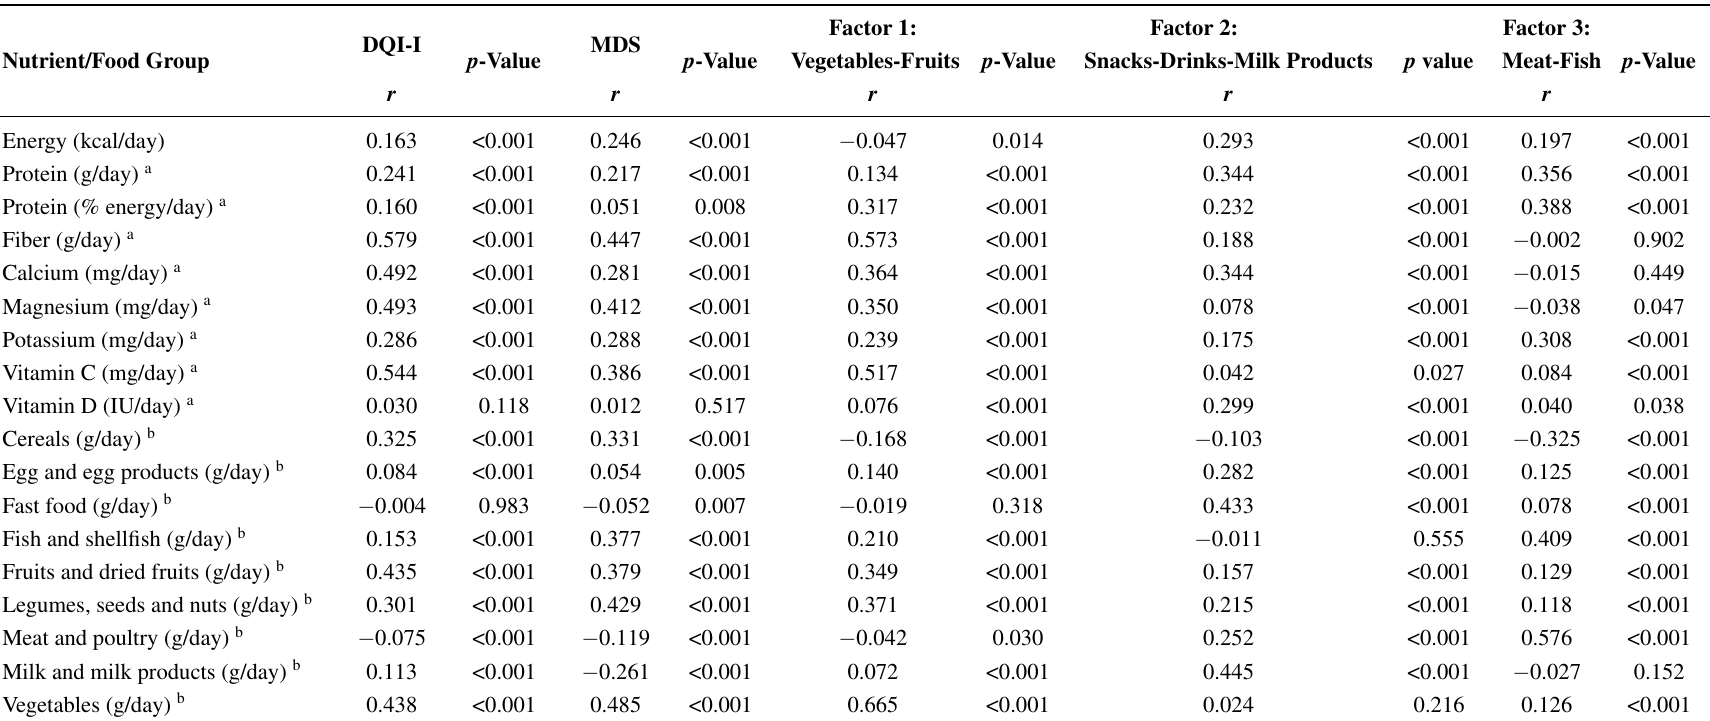
Table 3. Correlation between each dietary pattern score and selected nutrient intakes and food groups ( n =